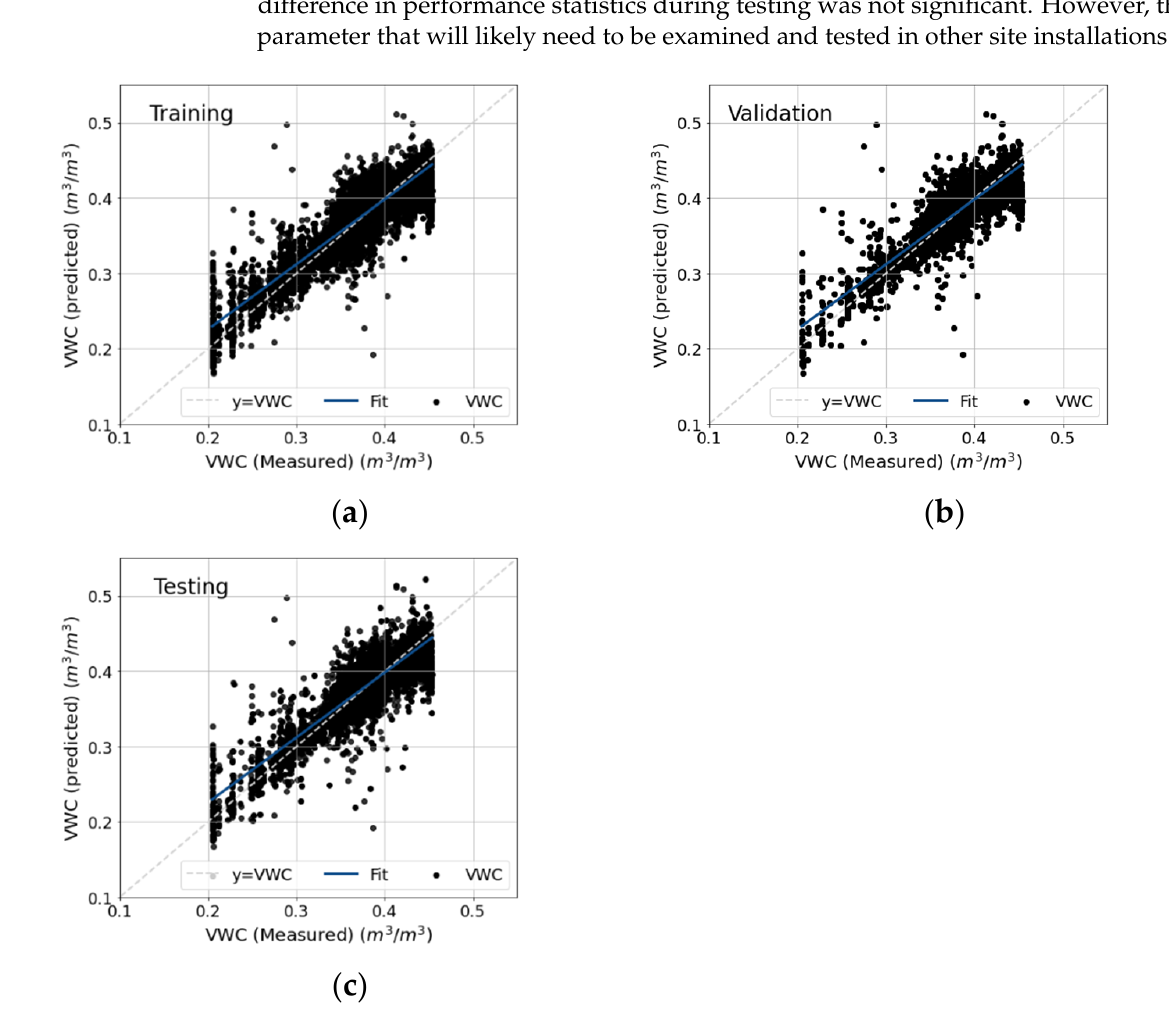
Figure 7. Measured and predicted soil volumetric water content (VWC) at training ( a ), validation ( b ), and testing ( c ) stages of the ANN–MLP model using input parameters: distance of the sensor node to the antenna (D), RSSI + 20 × log(D), relative humidity (RH), and soil and atmospheric temperature. Model is highlighted in bold on Table 2 as the best-performing model.